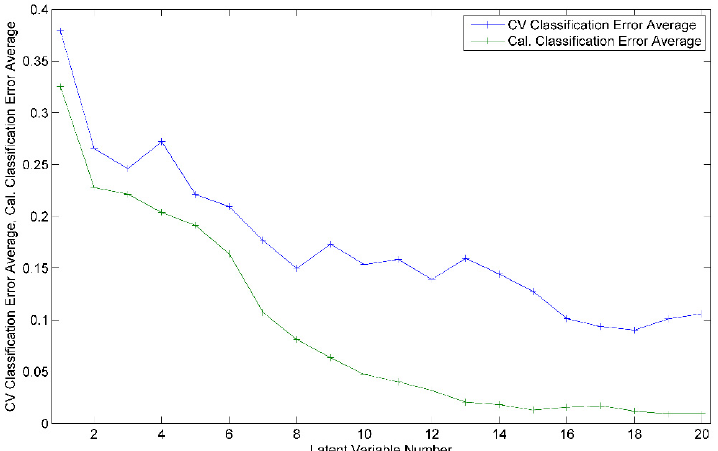
Figure 7. Cross-validation (CV) and calibration (Cal.) classification error average as function of the number of latent variables used for the PLS-DA model aiming at the botanical differentiation of the honey samples.